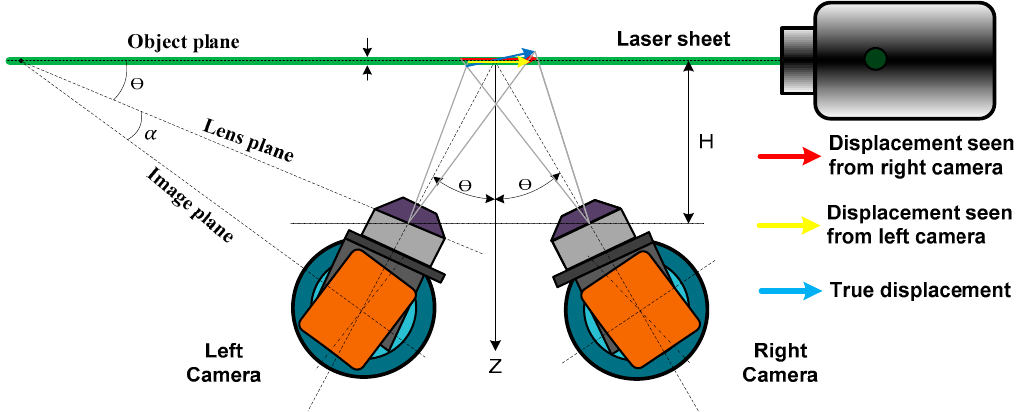
Figure 2. Scheimpflug stereoscopic camera configuration.